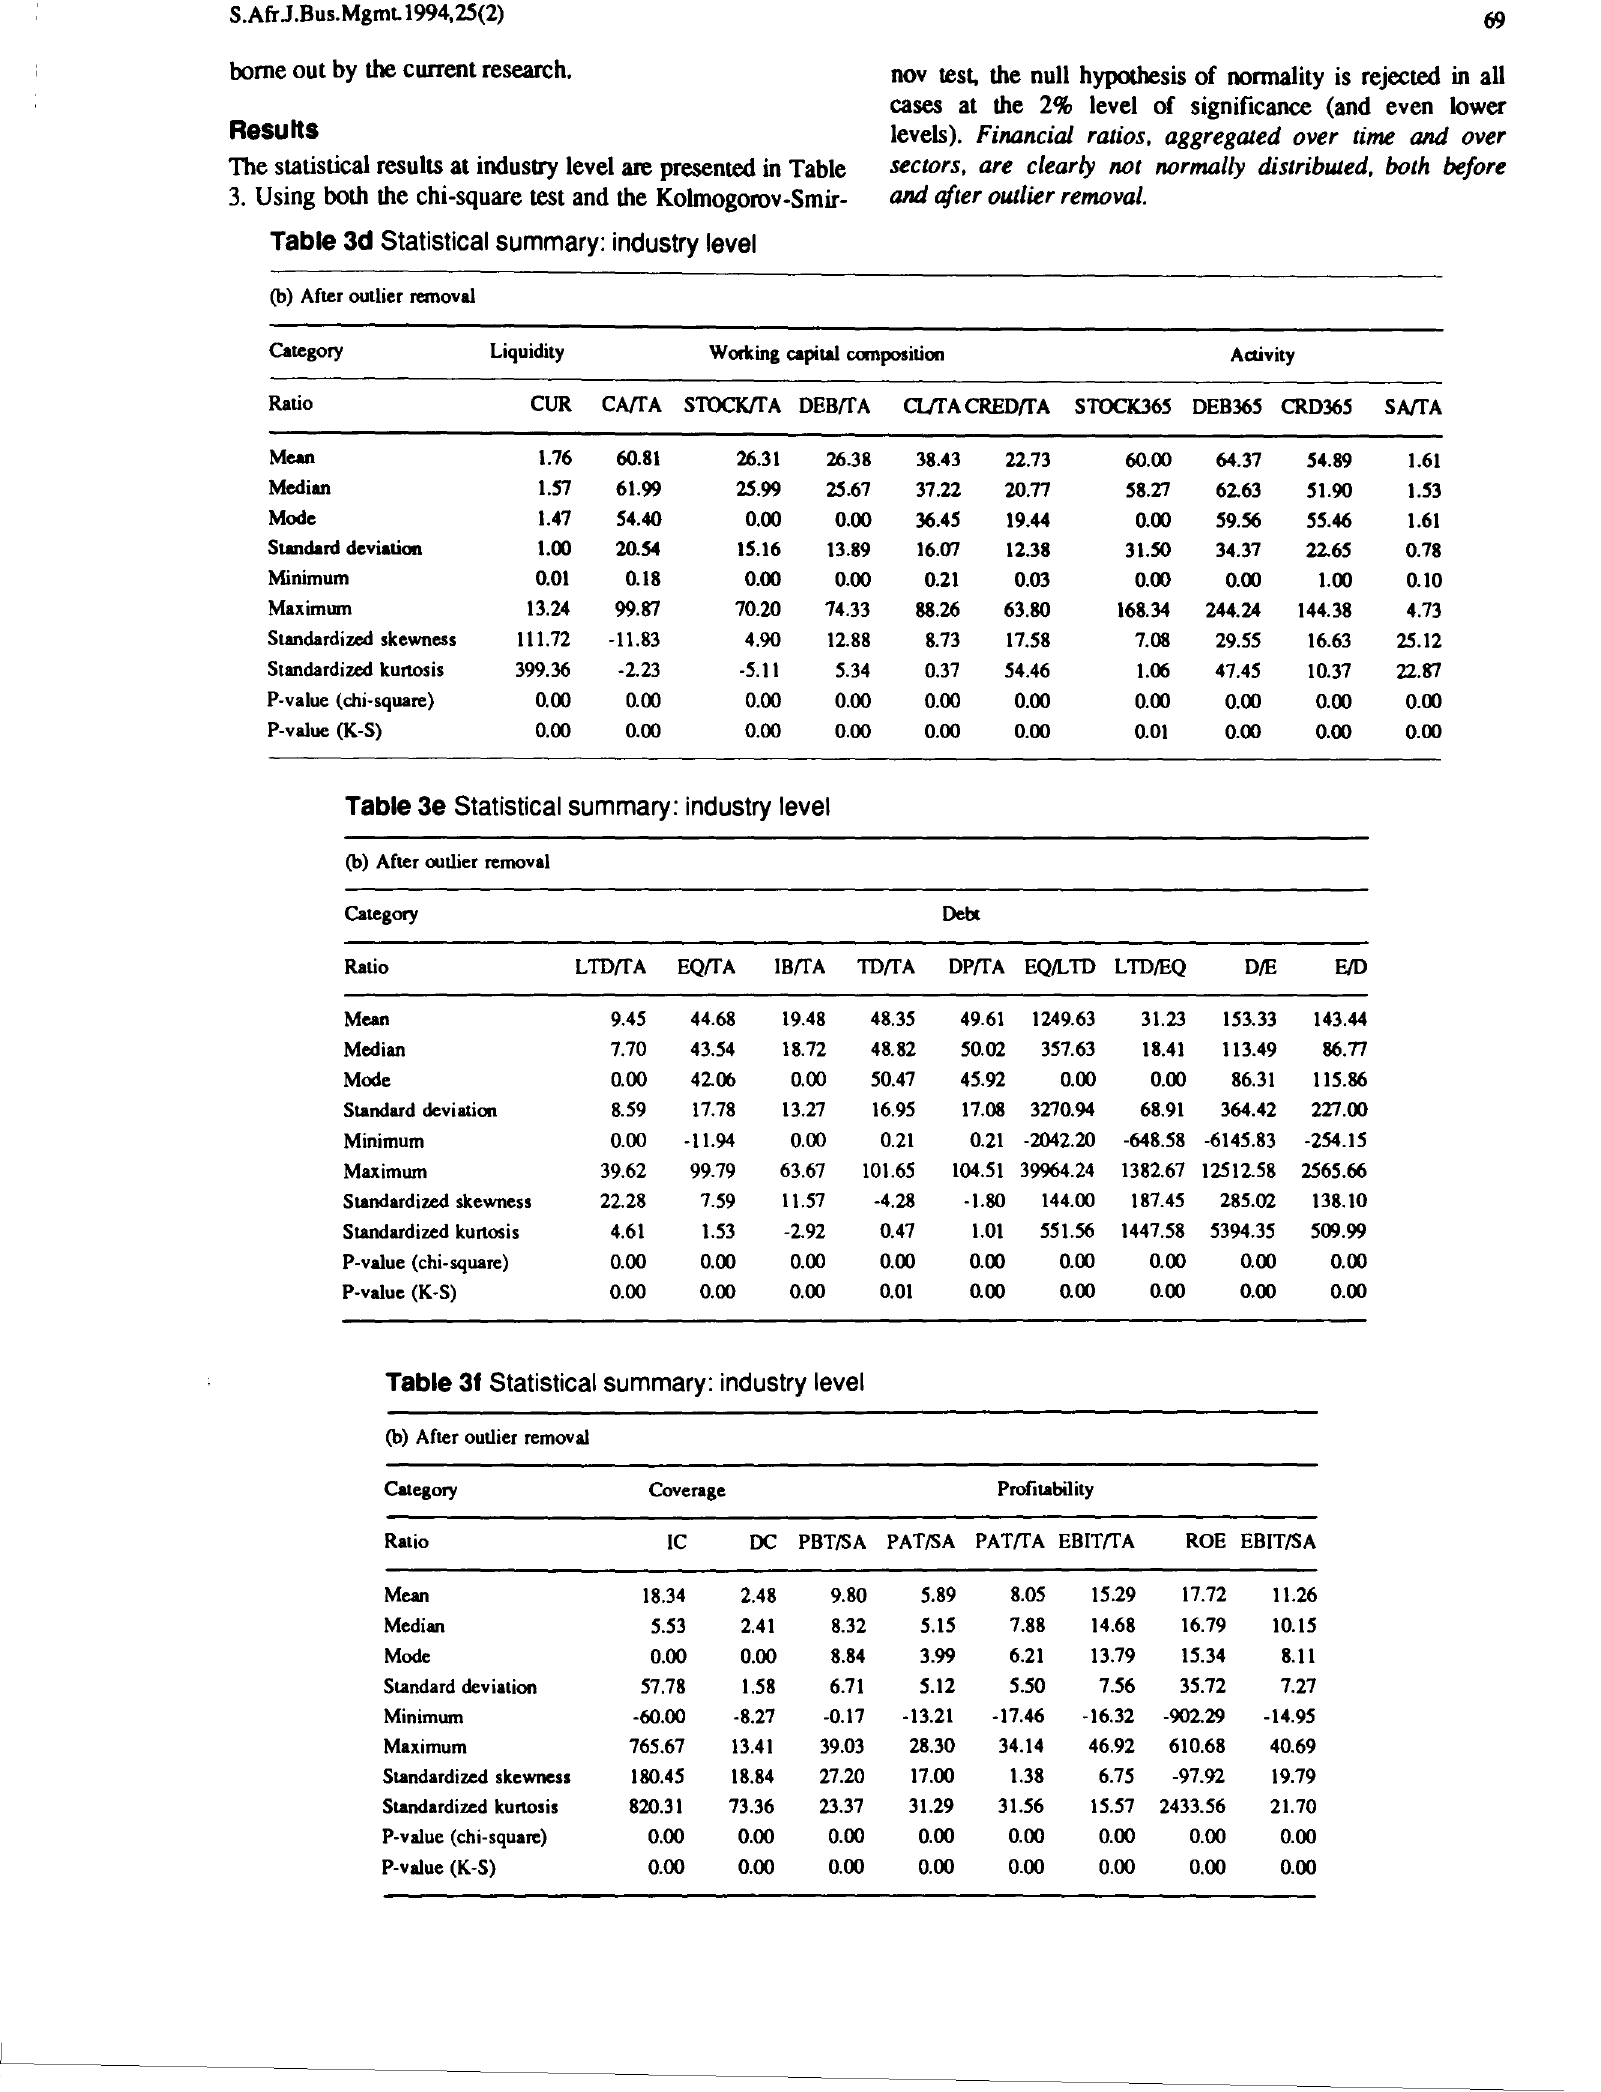
Table 3d Statistical summary: industry level